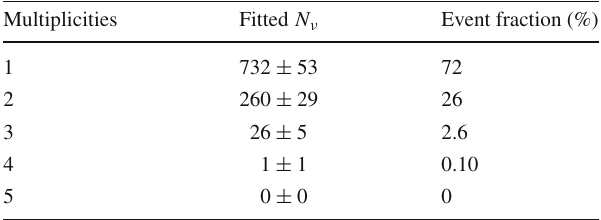
uncertainty estimates obtained from the fit. The percentages correspond to the fraction of events in each category